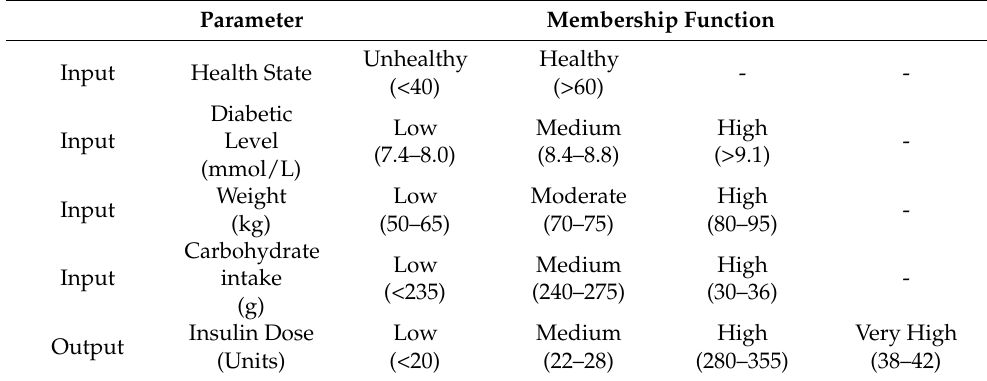
Table 5. Parameters for fuzzy system for insulin